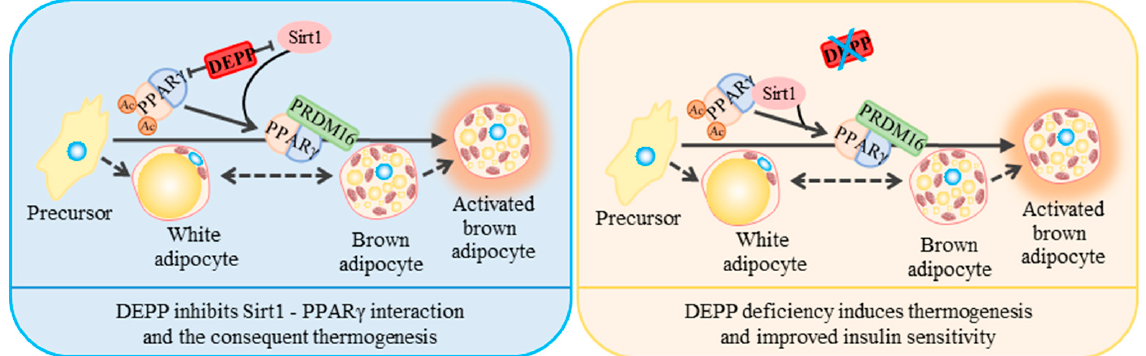
Figure 6. A model of a DEPP-mediated mechanism on regulating adipocyte browning.